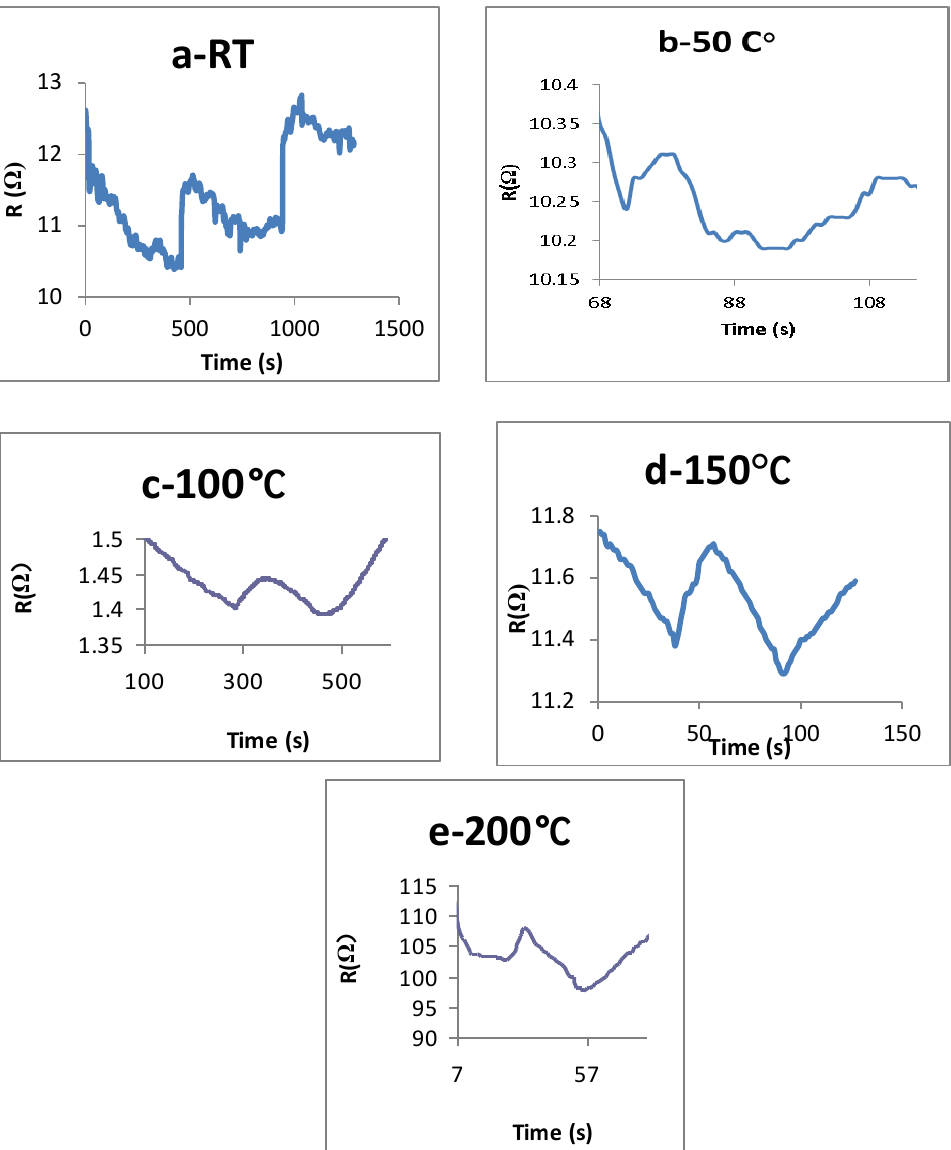
Fig.3: Resistance-time variation of F-SWCNTs sensor time at a-RT, b-50 c-100 d-150 and e-200 testing temperature upon exposure to NO 2